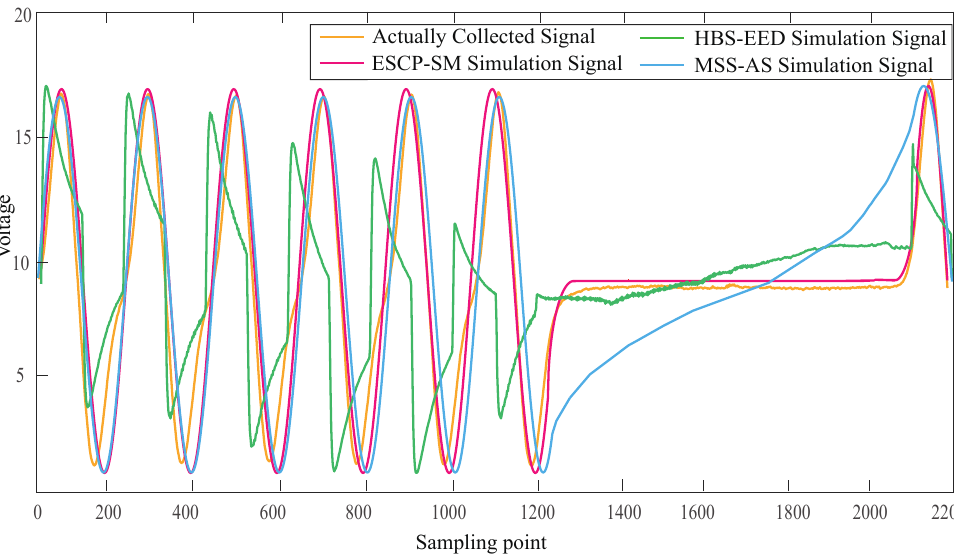
Figure 21. Local magnification of the four